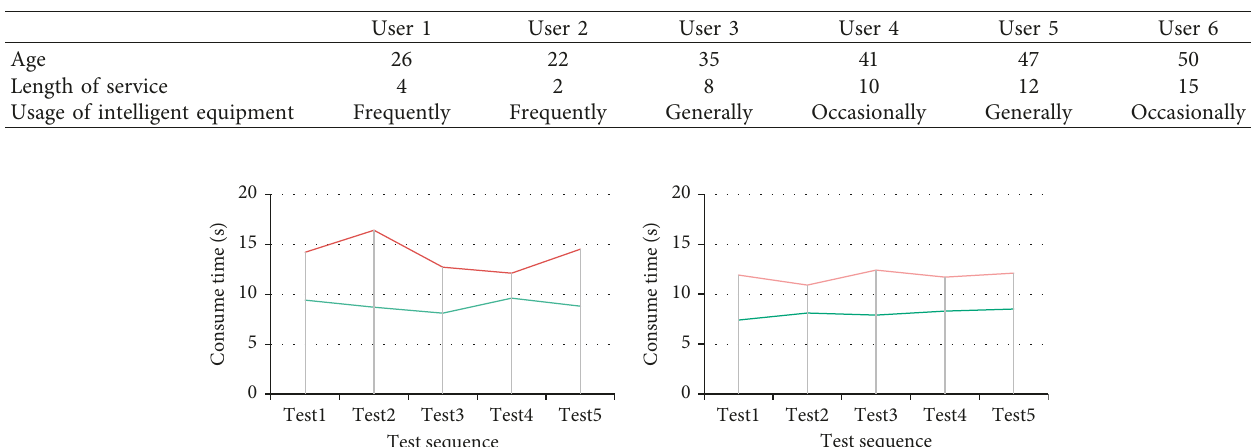
Figure 6: Outbound use case diagram. Table 5: User specific information.